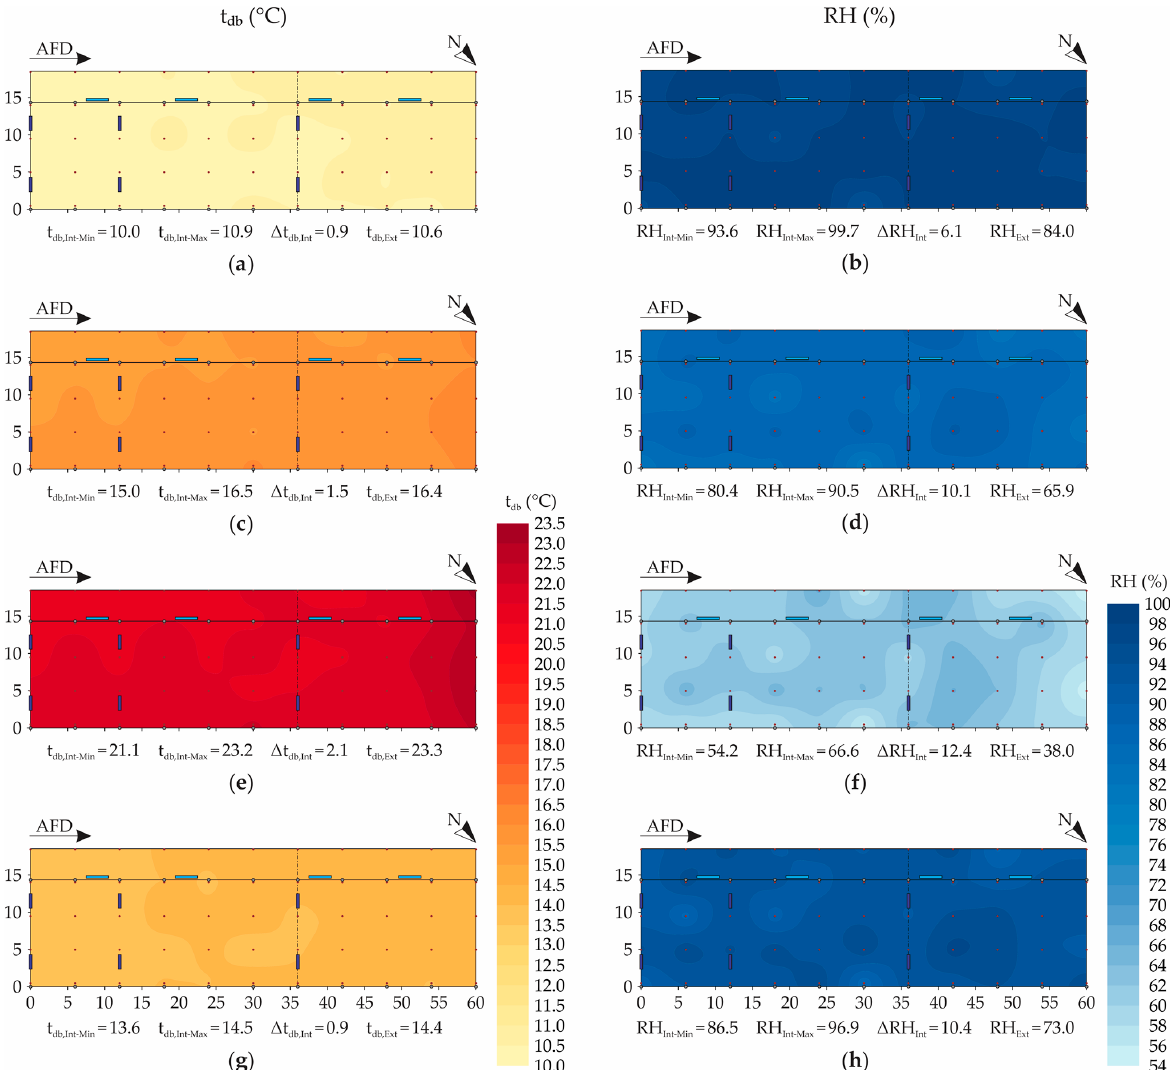
Figure 5. Spatial distribution of dry-bulb air temperature (t db , in °C) and relative humidity of air